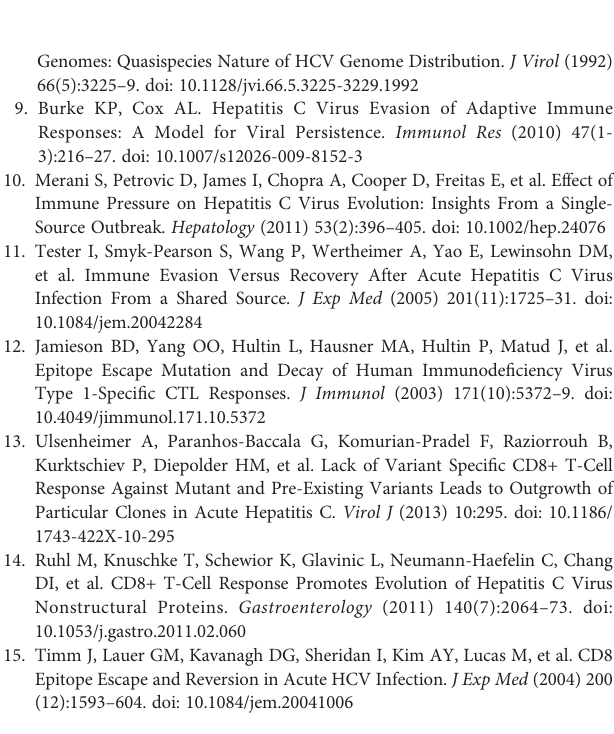
Supplementary Figure S1 | Distribution of dominant aminoacid sequences in epitope NS3 1073 among HLA-A*02-positive and HLA-A*02-negative patients. Amino acids are colored according to their chemical properties: polar amino acids (G, S, T, Y, C, Q, N) are green, basic (K, R, H) blue, acidic (D, E) red, and hydrophobic (A, V, L, I, P, W, F, M) amino acids are black. Height of letters within the stack indicates the relative frequency of each amino acid at this position. Sequence logos were generated using WebLogo generator (57). Supplementary Figure S2 | Distribution of dominant aminoacid sequences in epitope NS3 1406 among HLA-A*02-positive and HLA-A*02-negative patients. Amino acids are colored according to their chemical properties: polar amino acids (G, S, T, Y, C, Q, N) are green, basic (K, R, H) blue, acidic (D, E) red and hydrophobic (A, V, L, I, P, W, F, M) amino acids are black. Height of letters within the stack indicates the relative frequency of each amino acid at this position. Sequence logos were generated using WebLogo generator (57). Supplementary Figure S3 | Distribution of dominant aminoacid sequences in epitope NS3 1436 among HLA-A*01-positive and HLA-A*01-negative patients. Amino acids are colored according to their chemical properties: polar amino acids (G, S, T, Y, C, Q, N) are green, basic (K, R, H) blue, acidic (D, E) red and hydrophobic (A, V, L, I, P, W, F, M) amino acids are black. Height of letters within the stack indicates the relative frequency of each amino acid at this position. Sequence logos were generated using WebLogo generator (57). Supplementary Figure S4 | Percentages of peripheral blood CD8 + T-cells expressing PD-1/Tim-3 in 90 patients infected with either NS3 1436 prototype (GenBank EU255962.1) or variant epitope sequence as the dominant strain (upper panel). Lower panel shows intrahost aminoacid variability of this epitope where no variabilitydenotesthepresenceofasinglevariantandvariabilityindicates ≥ 2variant sequences. Horizontal lines represent median values. Supplementary Figure S5 | Evolution of dominant aminoacid sequences in epitope NS3 1073, NS3 1406 , NS3 1436 and percentages of CD8 + T-cells expressing PD-1/Tim-3 in the non-responder to treatment. PRE-TX-before treatment, POST- TX-post-treatment. Aminoacidsarecoloredaccordingtotheirchemicalproperties: polar amino acids (G, S, T, Y, C, Q, N) are green, basic (K, R, H) blue, acidic (D, E) redand hydrophobic (A,V, L,I, P,W,F, M) aminoacidsare black. Sequencelogos were generated using WebLogo generator